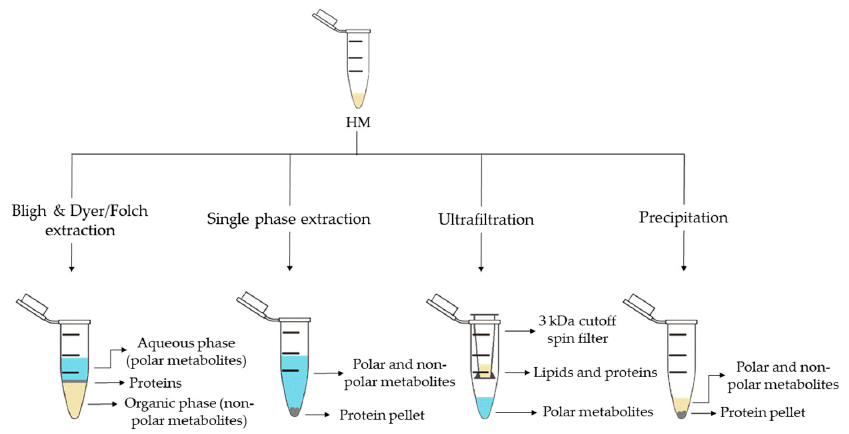
Figure 3. Sample preparation approaches employed in human milk (HM) metabolomics.